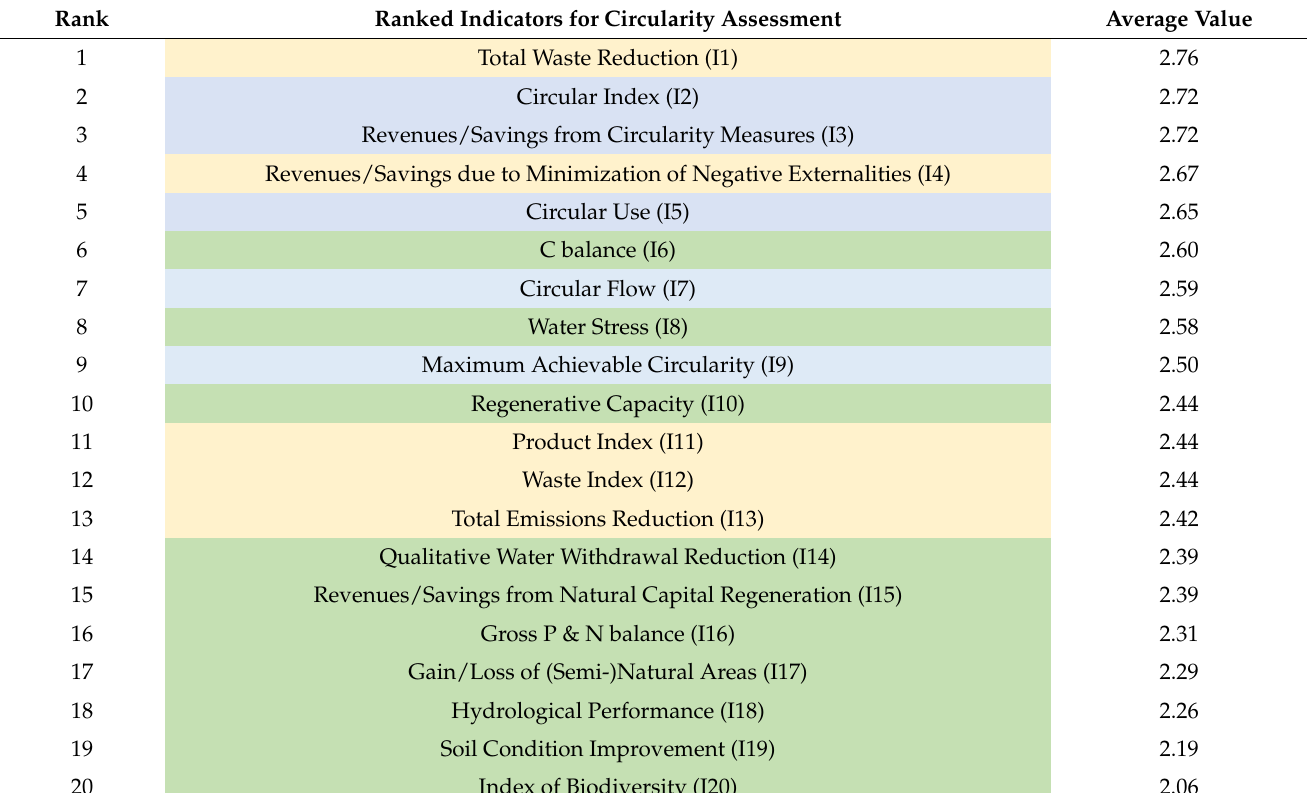
Table 1. Ranking of CPIs by industrial & academic